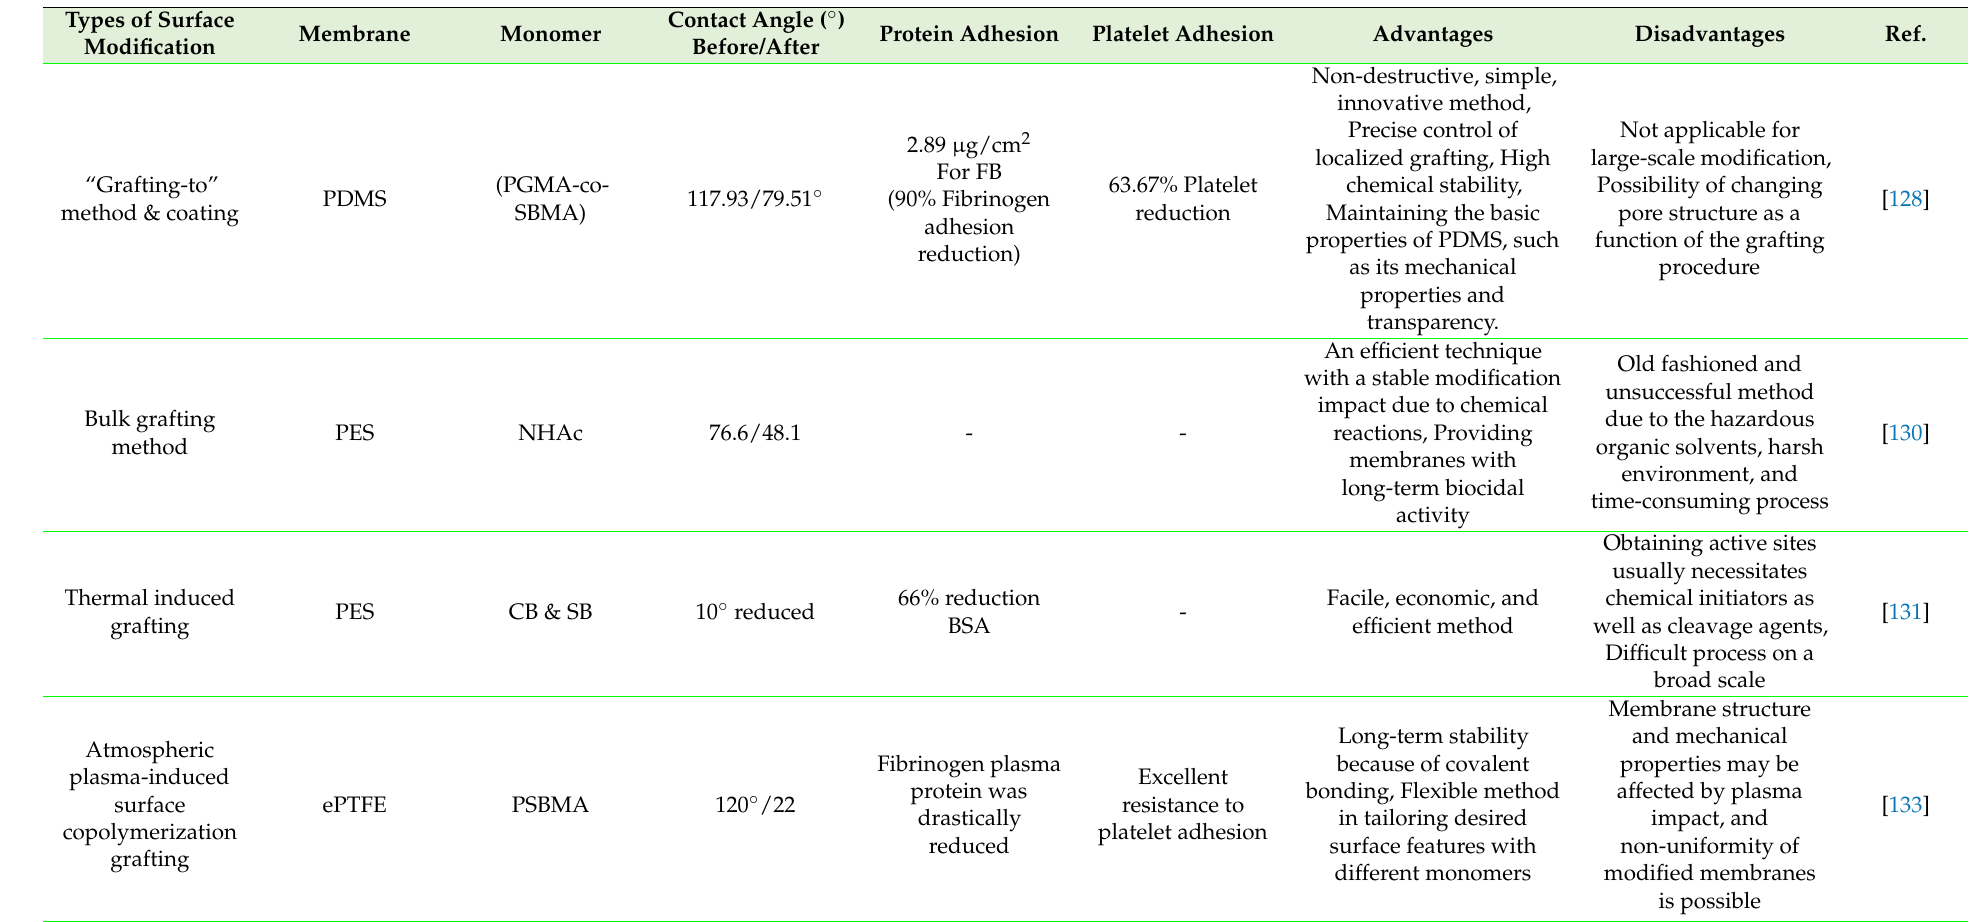
Table 3. Comparison of selected grafting